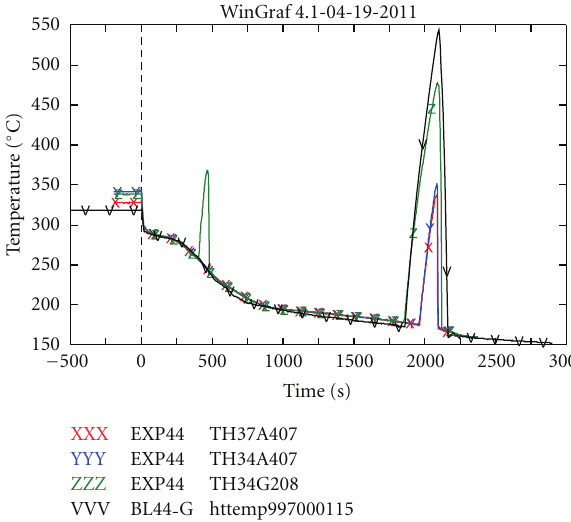
Figure 17: Cladding temperature at middle